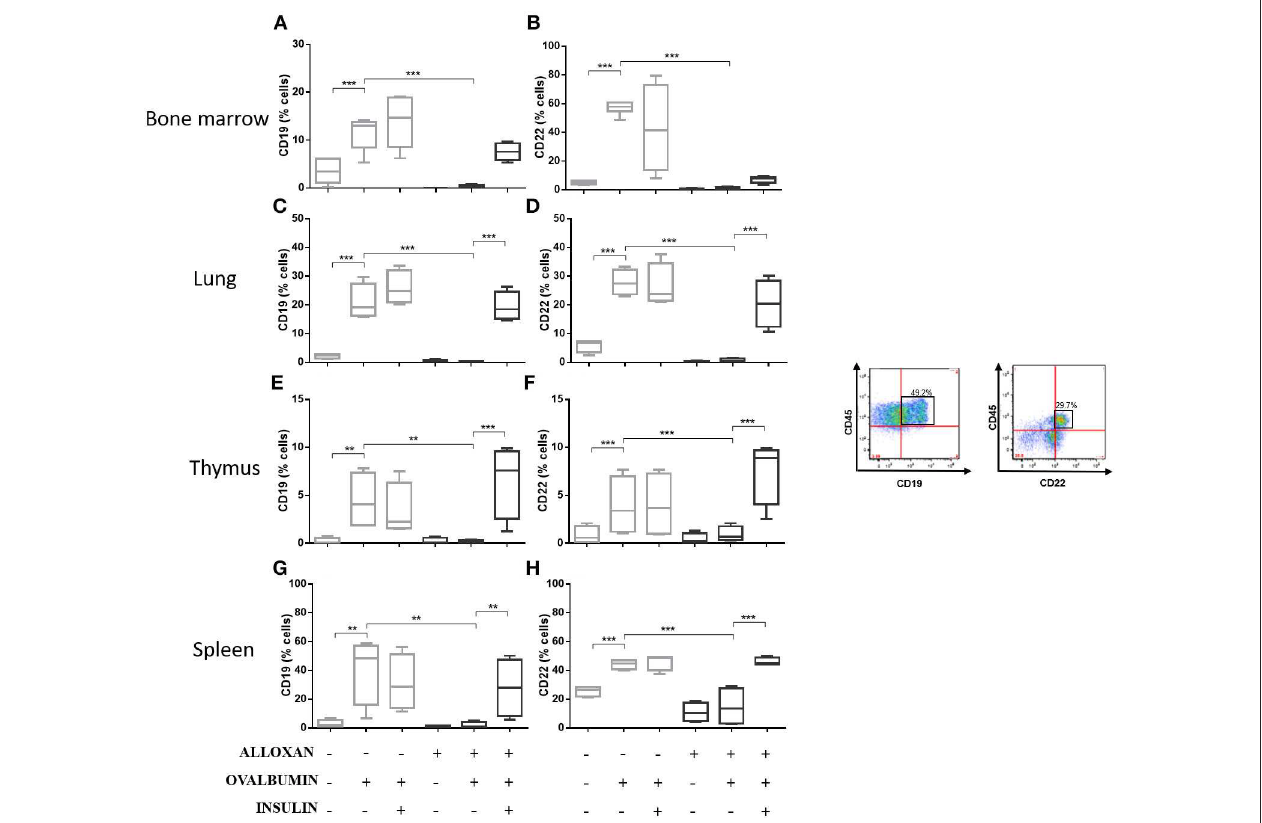
FIGURE 5 | Profile analysis of recruited B lymphocytes. Acquisitions were performed using an FACSCanto flow cytometer, and the data were analyzed using FlowJo software (Tree Star, Inc., USA). We analyzed 20,000 events. Representative dot plots showing the gating strategy used to identify B cells in the bone marrow, (A) CD19 and (B) CD22; lung, (C) CD19 and (D) CD22; thymus, (E) CD19 and (F) CD22; and spleen, (G) CD19 and (H) CD22. Values represent the mean ± SEM from three independent experiments ( n = 3 per group). ** p < 0.01; *** p < 0.001. The groups were tested with two-way analysis of variance followed by Tukey–Kramer post-hoc tests (GraphPad Prism version 6.0 for Windows, GraphPad Software, La Jolla, CA,